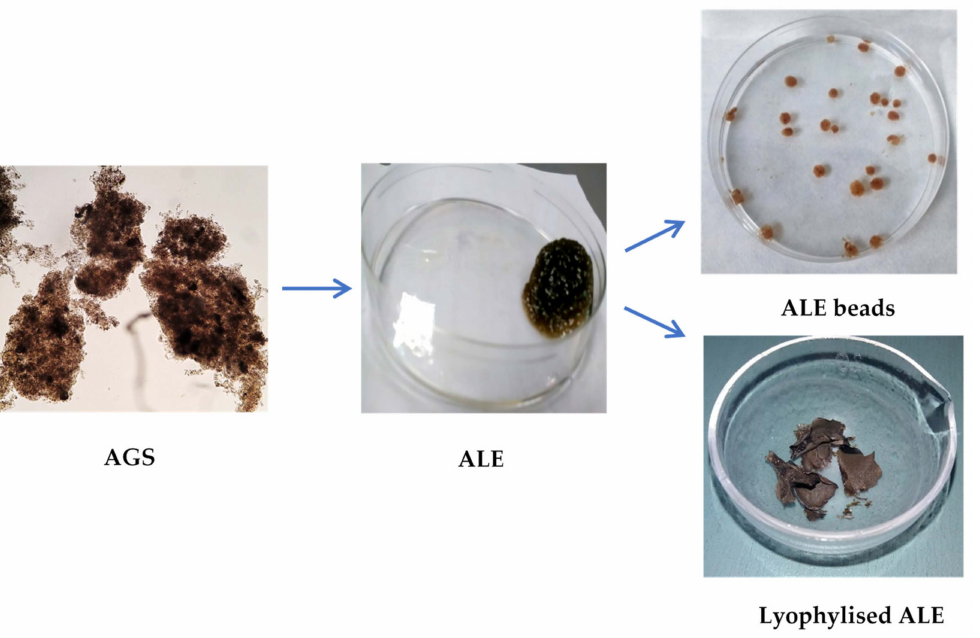
Figure 1. ALE extracted from AGS from a full-scale